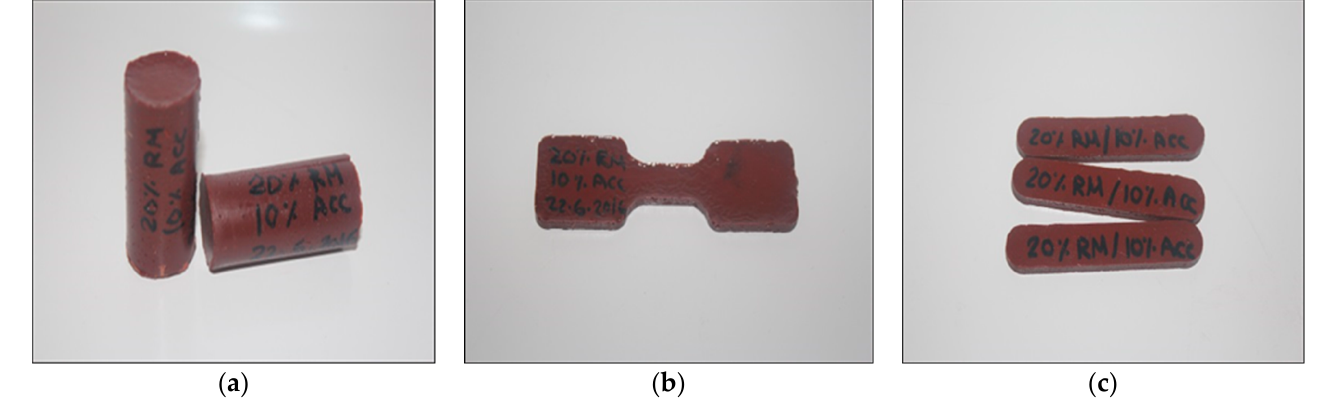
Figure 3. ( a ) Compression; ( b ) tensile; ( c ) flexural test